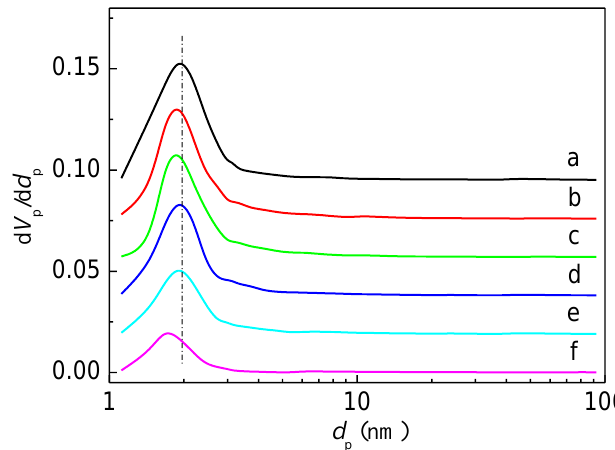
Figure 2. Pore size distribution of parent and P modified HZSM-5 zeolites: ( a ) HZSM-5, ( b ) 0.5% P/HZSM-5, ( c ) 1% P/HZSM-5, ( d ) 2% P/HZSM-5, ( e ) 3% P/HZSM-5 and ( f ) 5% P/HZSM-5.